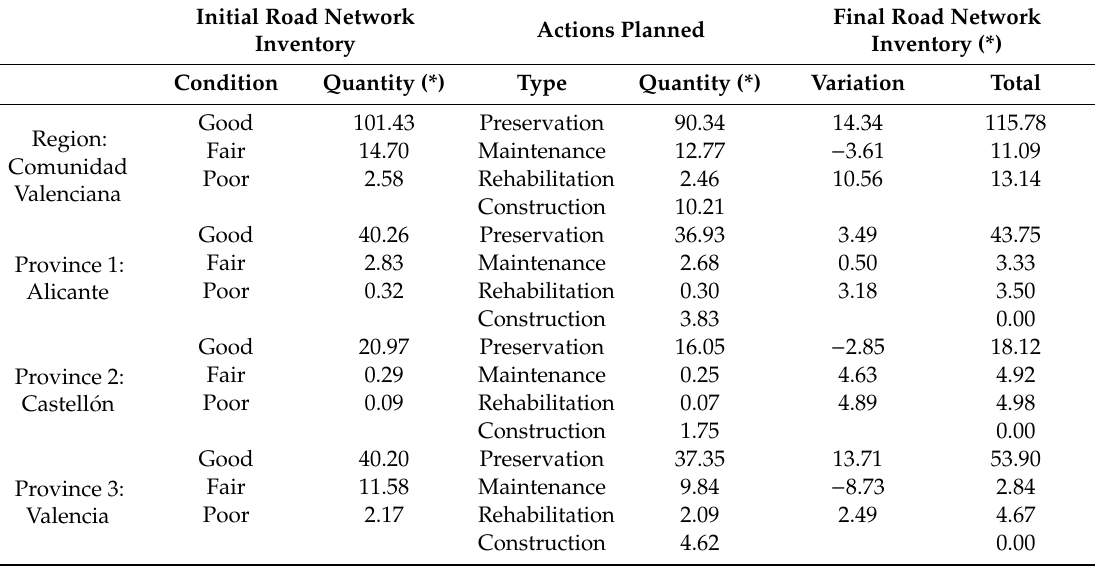
Table 2. Actions included in the selected planning alternative for the region of Comunidad